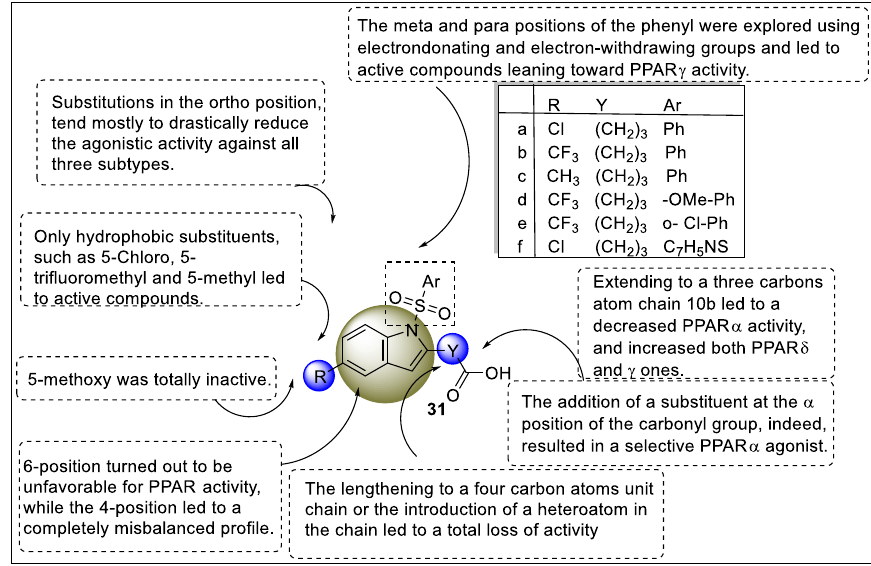
Figure 35. Structural activity relationship of indol hybrids ( 31 ) as potent PPAR ligands.